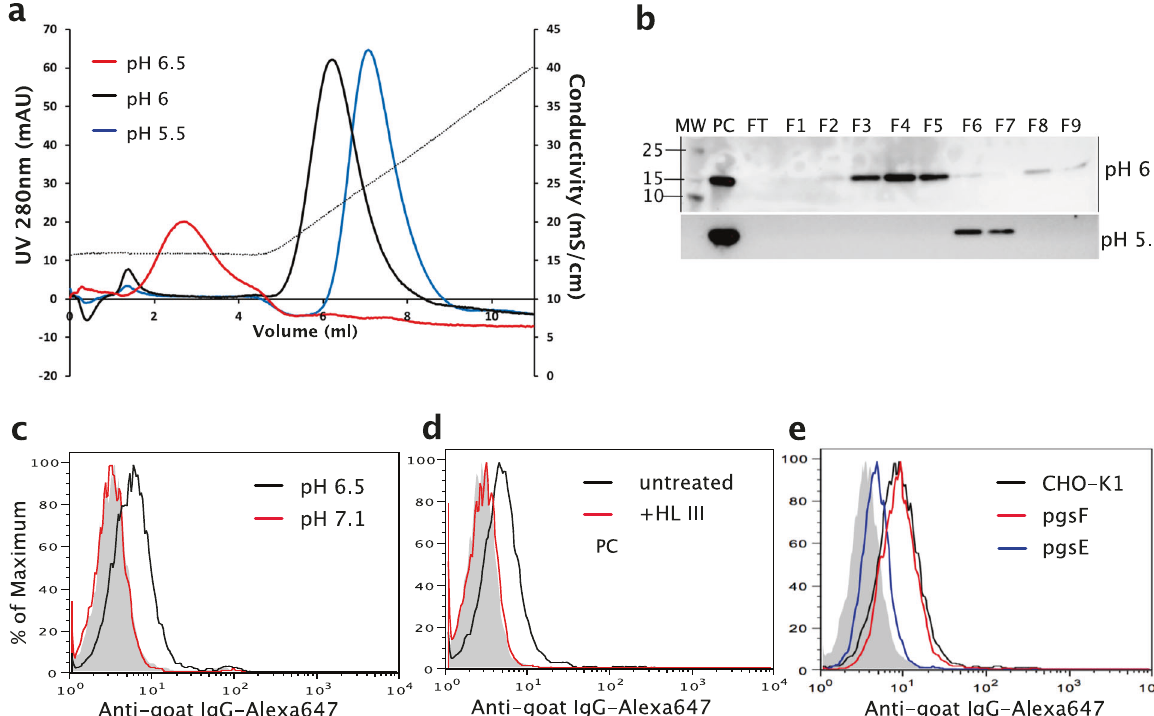
Fig. 1 Cst-3 binds to heparin and HS in a pH-dependent manner. a Binding of E.Coli expressed murine Cst-3 to heparin – Sepharose column at pH 5.5, 6, and 6.5. The dotted line represents the salt gradient (in conductivity mS/cm). b Western blot analysis of heparin – Sepharose chromatography fractions of 293 cells expressed murine Cst-3. The protein was loaded onto heparin – Sepharose column at pH 5.5 and pH 6 and 1 ml fractions were collected during the wash and elution. PC: positive control. FT: fl ow through. c Binding of Cst-3 (10 μ g/ml) to CHO-K1 cells was determined by a FACS-based binding assay at pH 7.1 and pH 6.5. The bound Cst-3 were detected by staining with a goat anti murine Cst-3 antibody, followed by anti-goat-IgG – Alexa647. The shaded histogram is from cells stained only with primary and secondary antibodies. d Binding of Cst-3 to CHO-K1 cells pretreated with heparin lyase III (HL-III) at pH 6.5. e Binding of Cst-3 to pgsE and pgsF, two mutant CHO cells lines with altered HS